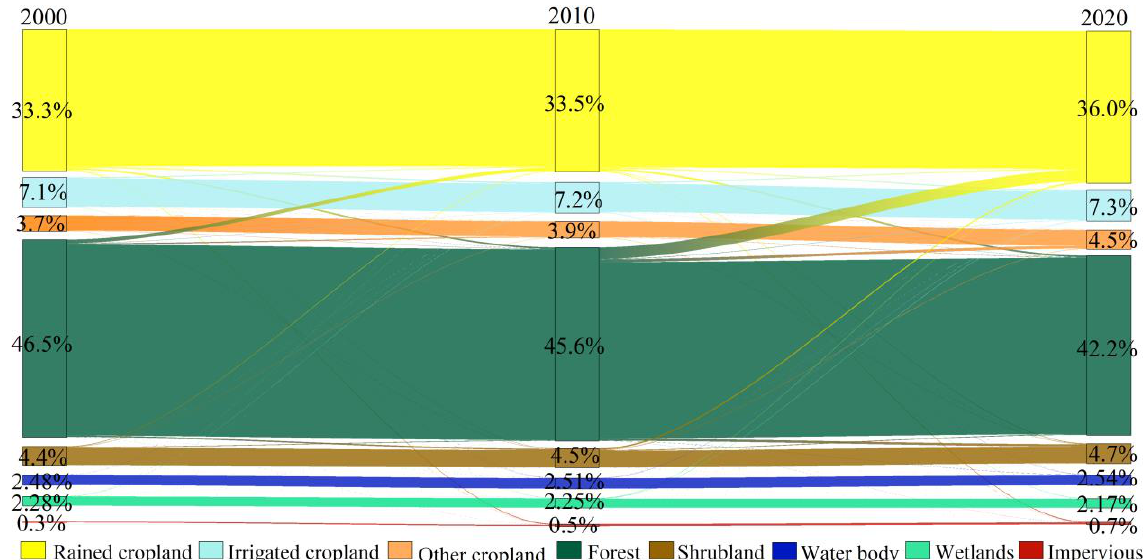
Figure 4. Land-use/land-cover transfer plot in Cambodia during 2000 – 2020.